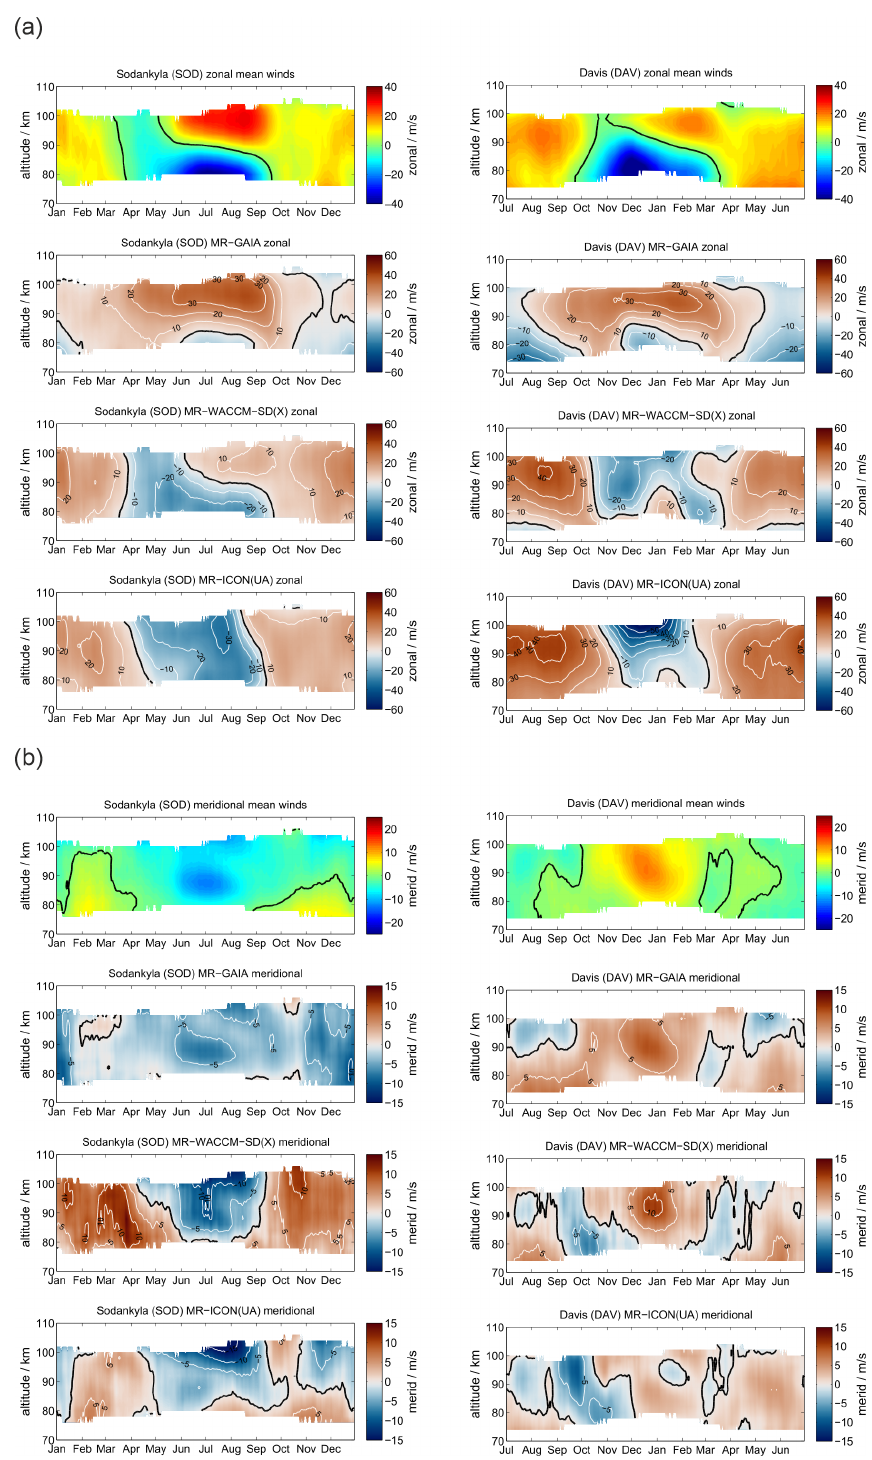
Figure B1. Absolute difference plots for mean winds from meteor radar and model fields for SOD and DAV.